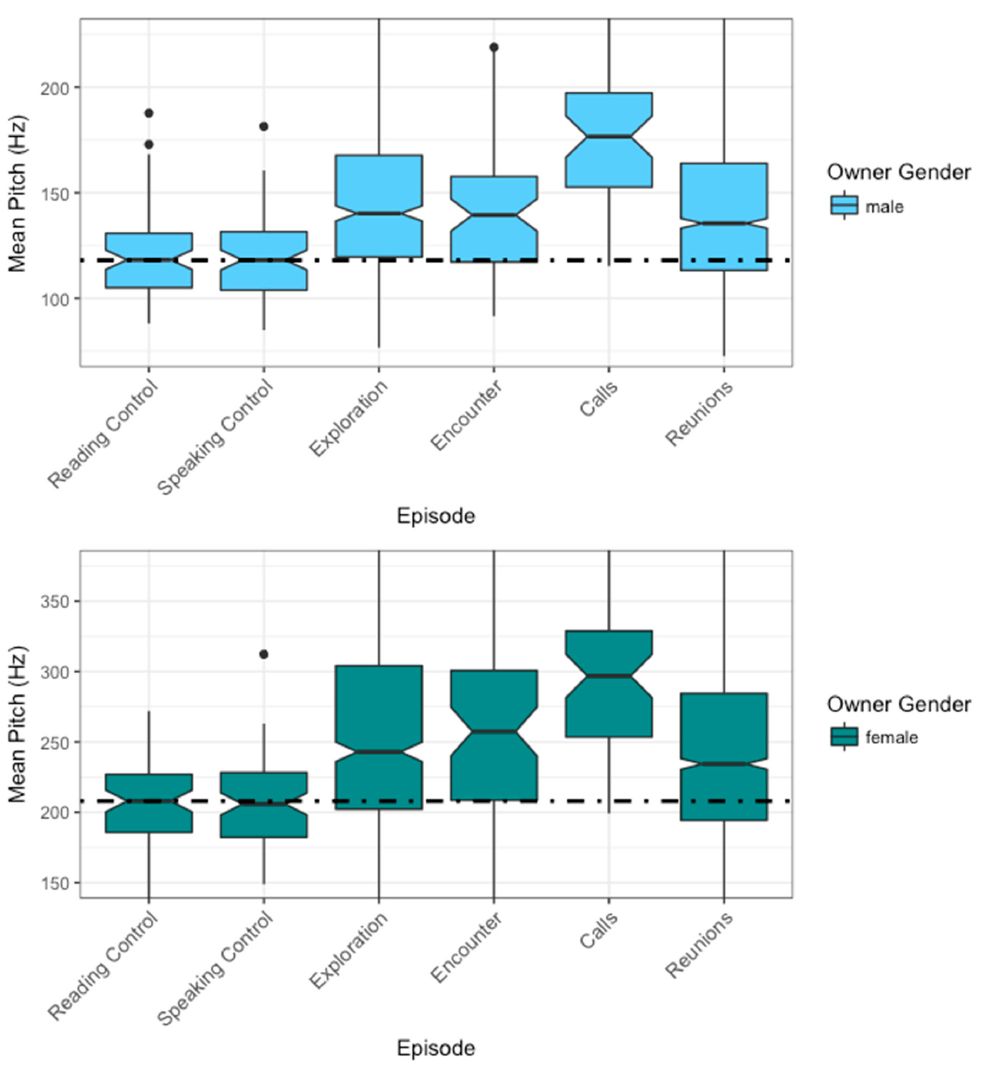
Figure 3. Change in mean pitch by gender over the ASS procedure episodes. The male owners are represented in light blue and the female owners in dark blue. Due to physiological differences, pitch (f0) is separated by about an octave between men and women. Therefore, results are presented in separate graphs (mean pitch plotted by gender over ASS procedure (ASSP) episodes, with the dashed line representing the reading controls median. The two calls and reunions are visualized combined as “calls” and “reunions”.) n = 53; number of observations = 4121.